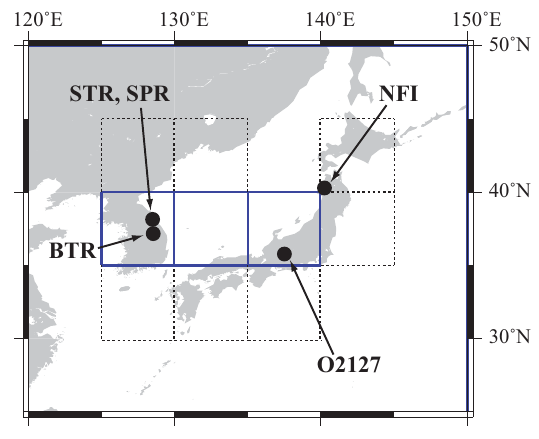
Fig. 1. Map of northeast Asia. Black dots indicate forest sites used for the final calibration. STR, SPR, BTR (Choi et al., 1994), and O2127 (Yonenobu and Eckstein, 2006) were previously de- veloped, while NFI was newly developed in this study. The grids with dotted and blue lines show the gridded land air temperature data (CRUTEM4) (Jones et al., 2012) used for the calibration tri- als and the final calibration,